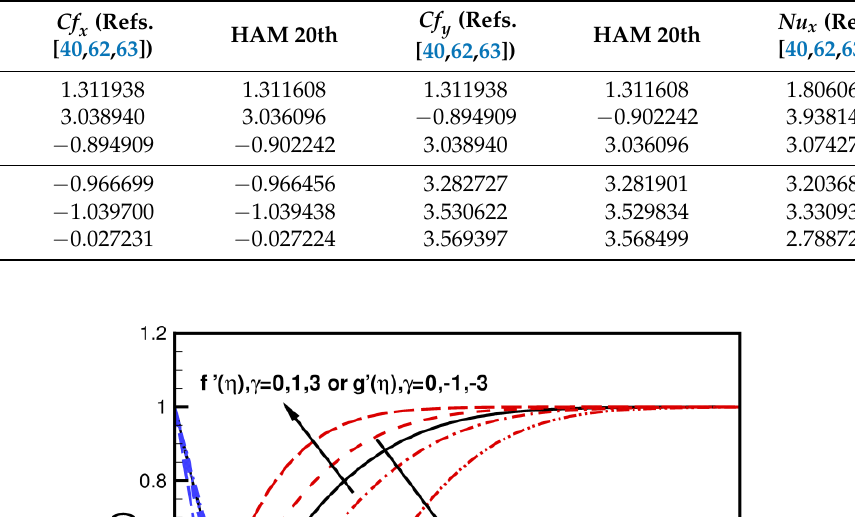
Table 3. Skin friction coefficients Cf x , Cf y and Nusselt numbers Nu x with various values of γ , φ and σ when Pr = 6.2.